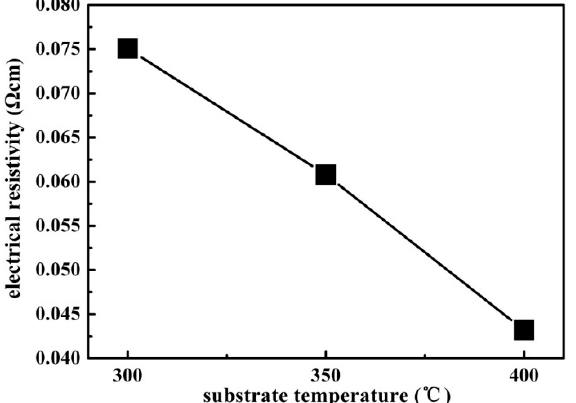
Figure 5. The electrical resistivity of AlSb:Zn thin films deposited at different substrate temperature.